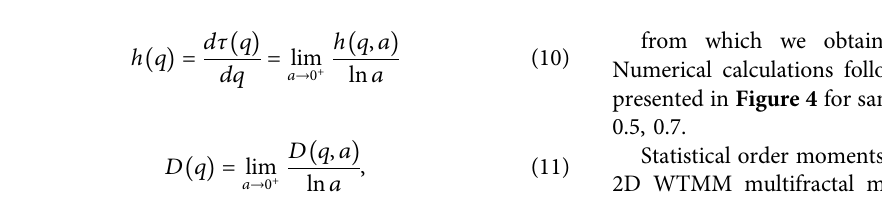
Frontiers in Physiology |